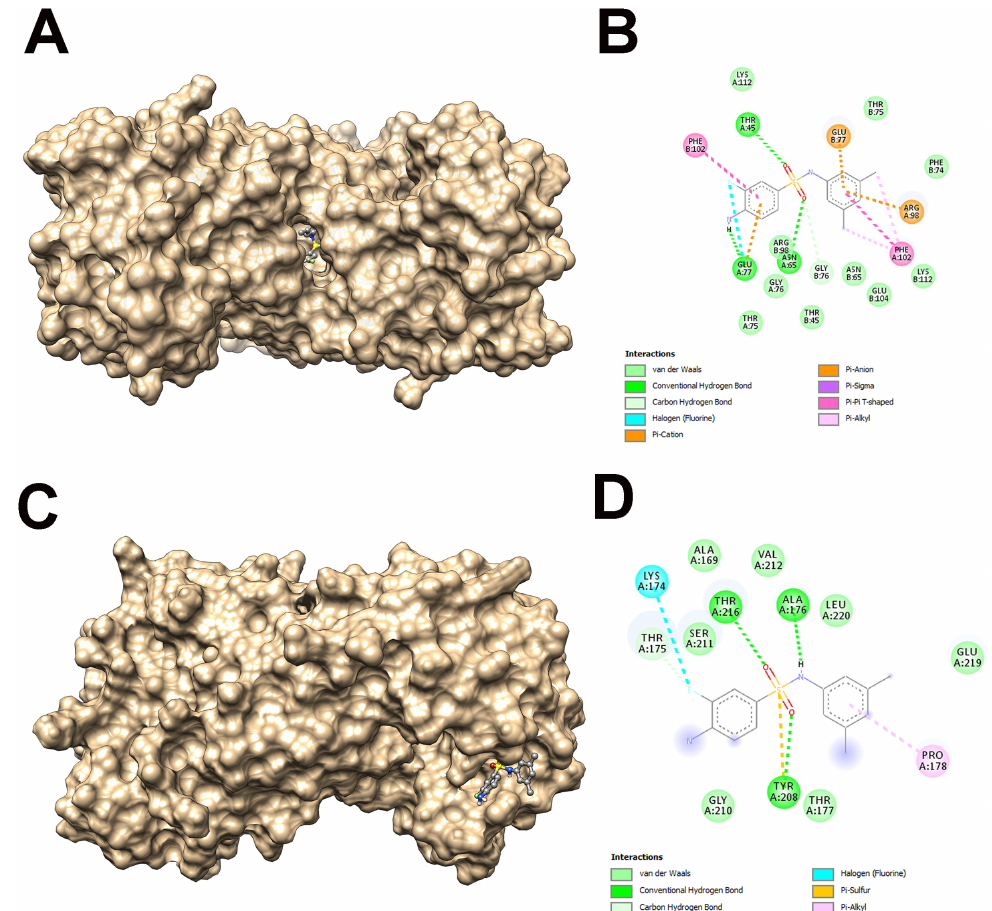
Figure 7 Complex showing interaction between sulfaE and hTPI. (A) hTPI-dimer interface binding pocket. (B) 2D ligand interaction diagram showing dimer interface residues. (C) hTPI-Active Site. (D) 2D ligand interaction diagram showing active site